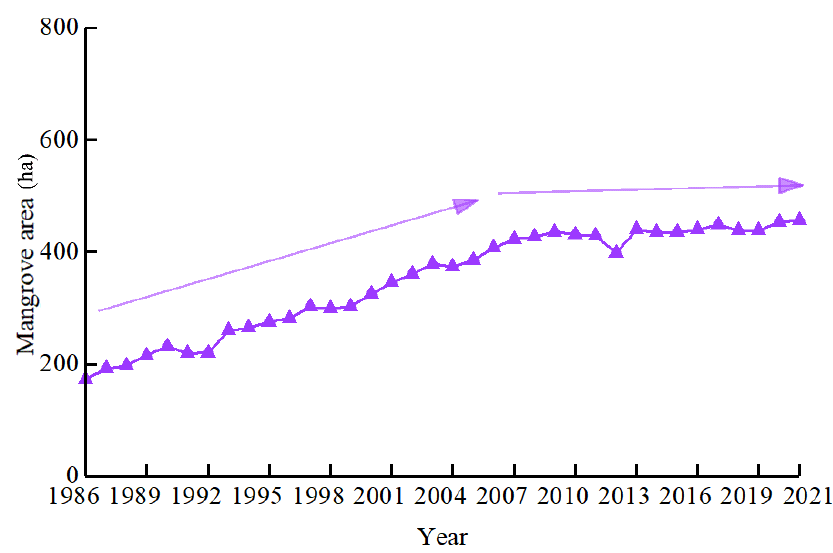
Figure 10. Mangrove area in MMNR during 1986 – 2021.